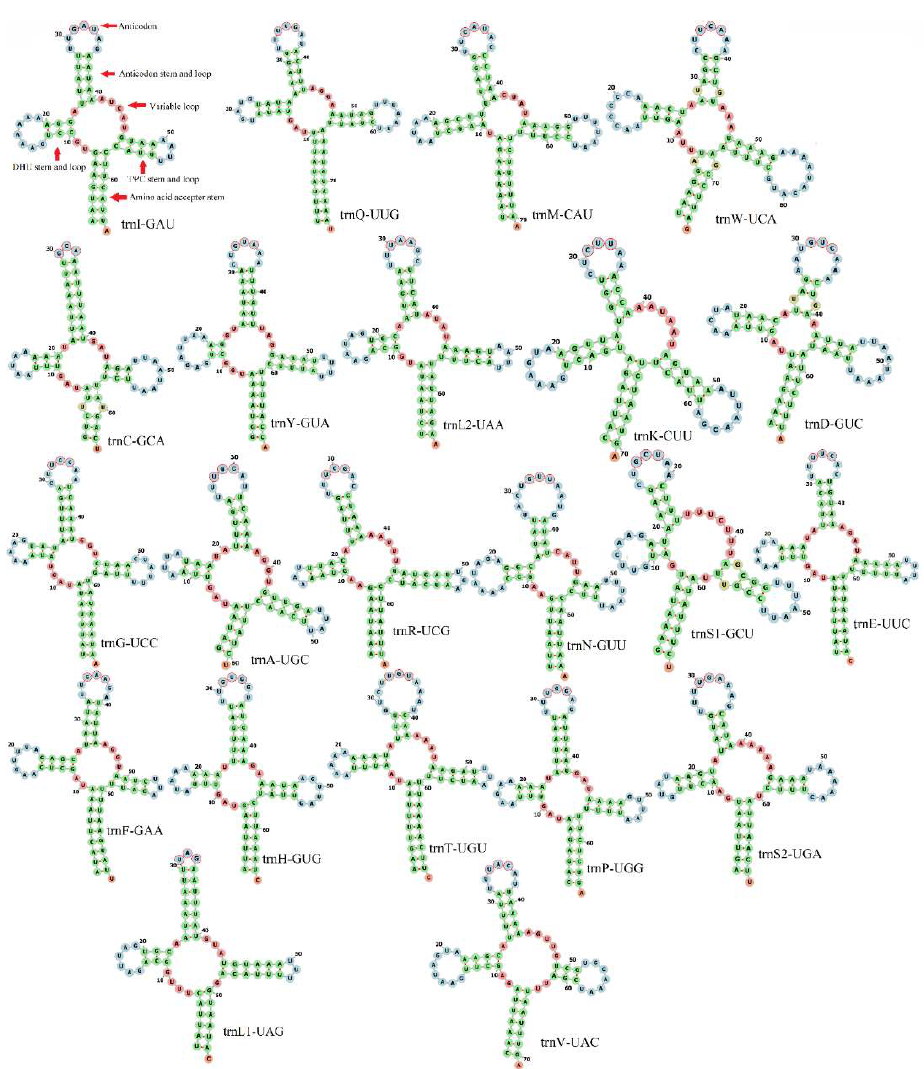
Figure 4. Secondary structure of 22 tRNAs of G. orientalis mitogenome. The mismatched base pairs are presented in yellow; the matched base pairs are presented in green; the bases in the loop are presented in blue; and the nucleotide outlines of the anticodon are presented in red.